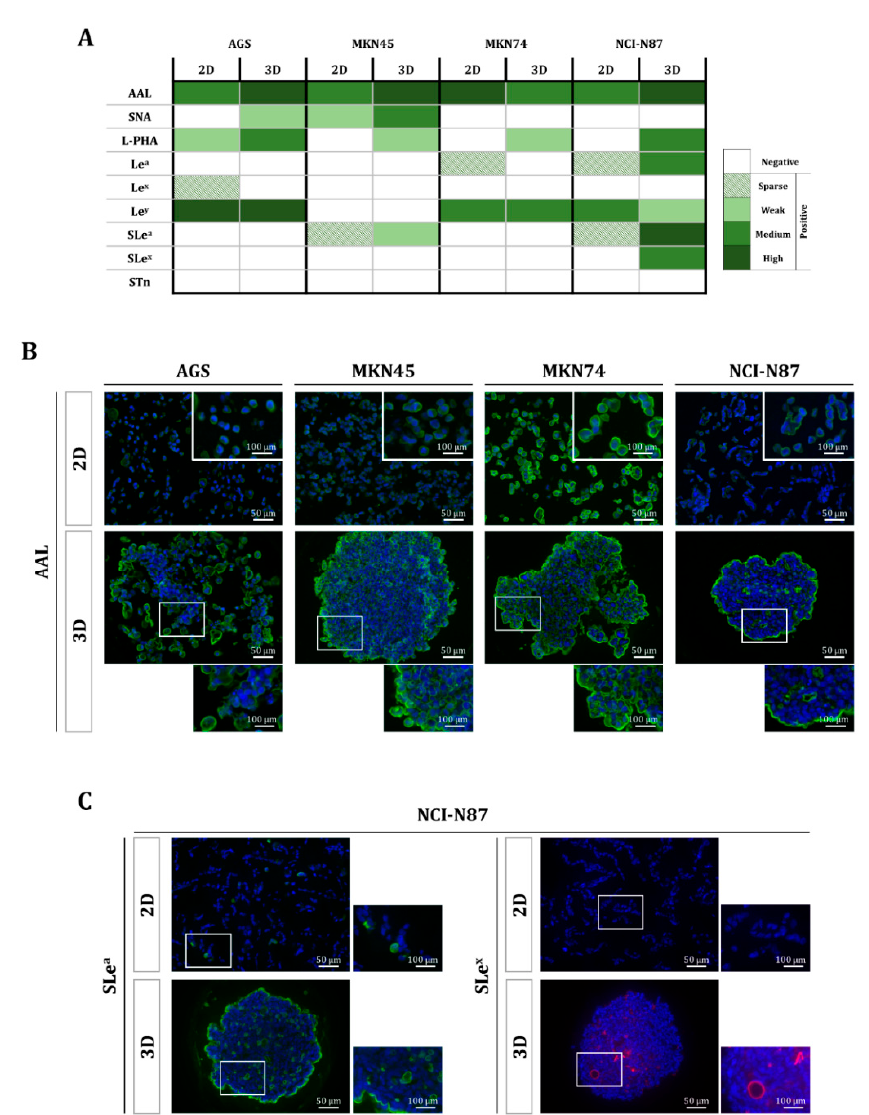
Figure 4. Glycan profiling of the gastric multicellular tumor spheroids. ( A ) Immunofluorescent staining of a panel of lectins and antibodies for glycosylation characterization of gastric cancer cell lines grown in 2D or 3D cell culture conditions. ( B ) Aleuria aurantia lectin staining, detecting fucosylation, is shown as a representative example for the four cell lines. ( C ) Differential expression of antigens sialyl Lewis A (SLe a ) and sialyl Lewis X (SLe x ) for the NCI-N87 cell line.